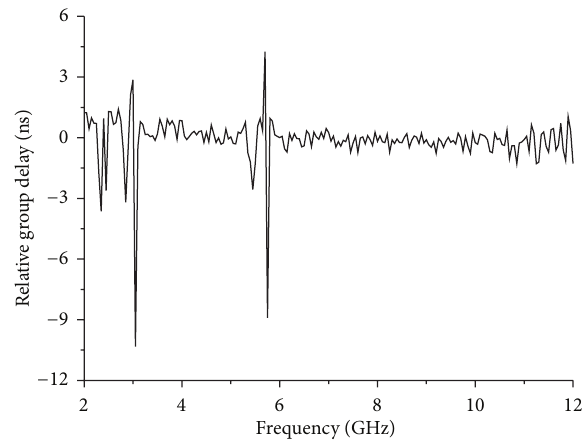
Figure 14: Frequency-domain behavior of the group